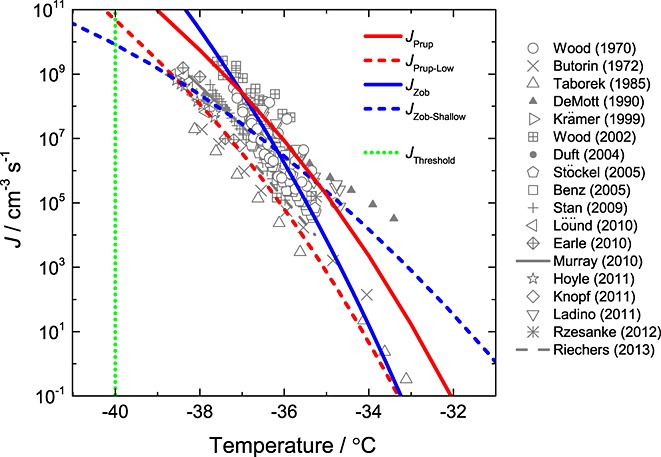
Homogeneous ice nucleation rate coefficient data determined from laboratory measurements (grey symbols and lines) and estimated using CNT following Pruppacher [1995] and Zobrist et al. [2007] (solid red and blue lines). Additional parameterizations adapted from the CNT-based lines and constrained by the measurements are shown as dashed red and blue lines. A threshold freezing approximation of −40°C is also included, shown as a temperature-independent step function (green dotted line). The data are taken from Benz et al. [2005], Butorin and Skripov [1972], Demott [1990], Duft and Leisner [2004], Earle et al. [2010], Hoyle et al. [2011], Knopf and Rigg [2011], Krämer et al. [1999], Ladino et al. [2011], Lüönd et al. [2010], Murray et al. [2010], Riechers et al. [2013], Rzesanke et al. [2012], Stan et al. [2009], Stöckel et al. [2005], Taborek [1985], Wood and Walton [1970], and Wood et al. [2002]. A table of equations for each parameterization can be found in Table S2 in the supporting information.